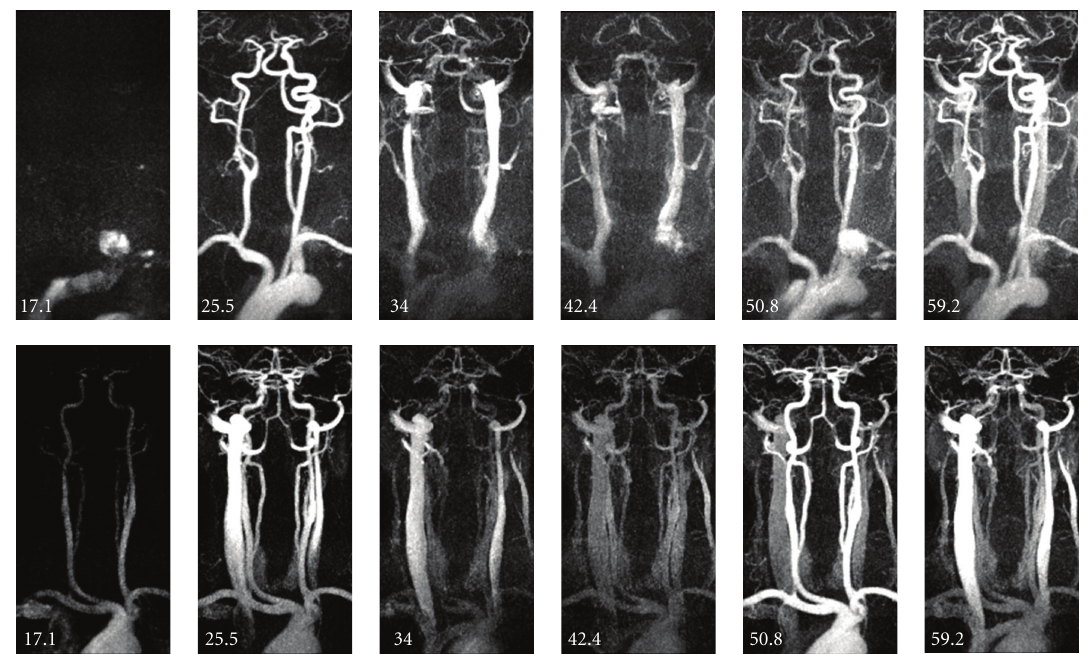
Figure 2: Top row: MR-angiogram with optimal arterial contrast after first bolus ( t = 25 . 5 s). Bottom row: MR-angiogram with optimal arterial contrast after second bolus ( t = 50 . 8 s). Note that the first time frame is not